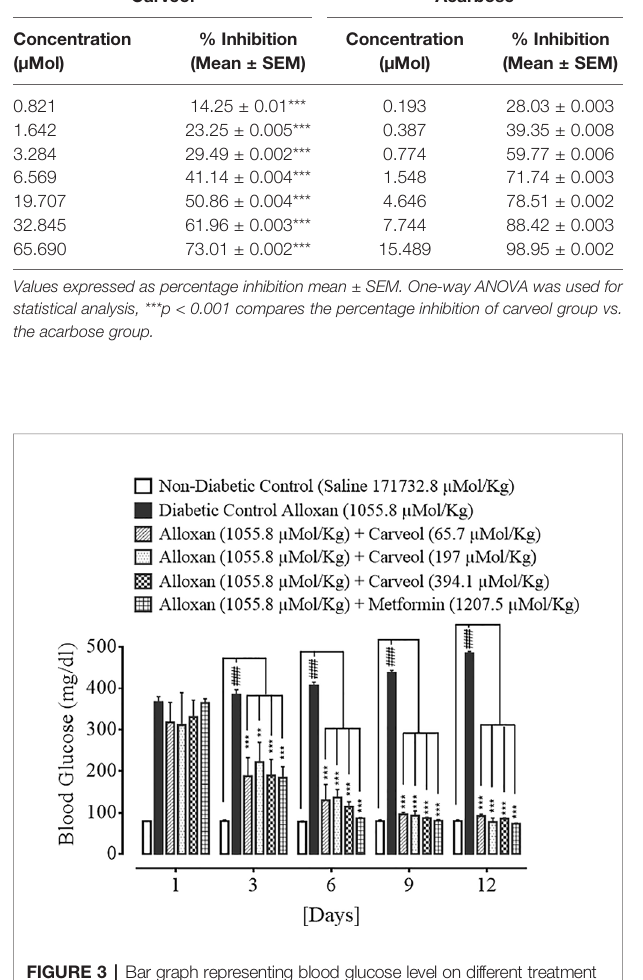
TABLE 2 | Alpha-amylase inhibitory effect of carveol and acarbose. Carveol Acarbose Concentration (µMol)